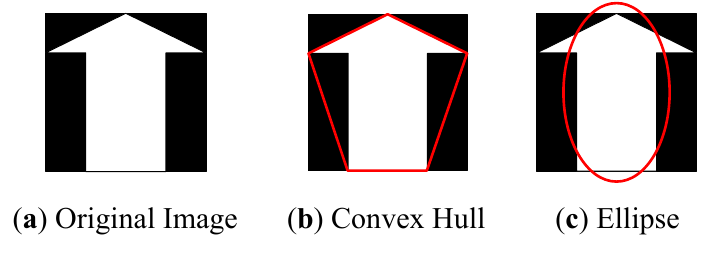
Figure 3. Illustration of the morphology measures.